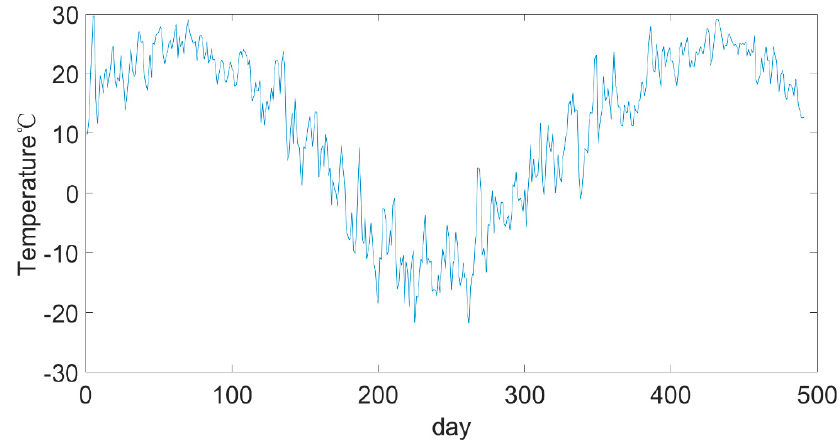
Figure 5. Average daily temperature from May 2019 to September 2020.